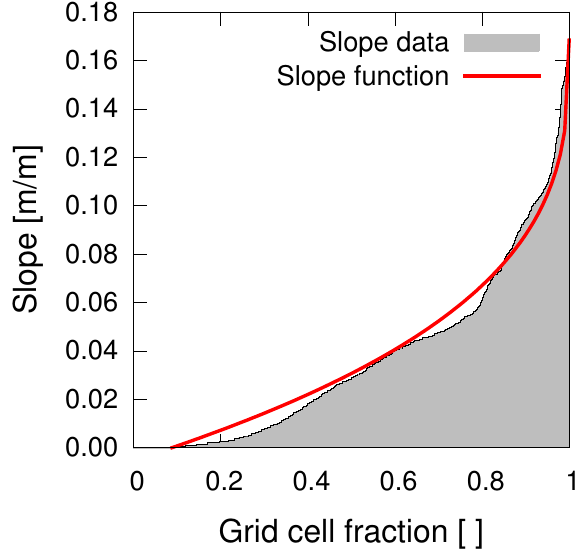
Fig. 1. Conceptual sketch of wetland water inflows (blue curve) and outflows (red curve) in dependence on the wetland’s surface area. The stable wetland extent (green line) is found on the intersection of both curves and depend on climatic forcing during the respective model time step and the topography of the grid cell. The blue shaded area indicates excess water if the inflow exceeds the outflow and vice versa for the red shaded area.